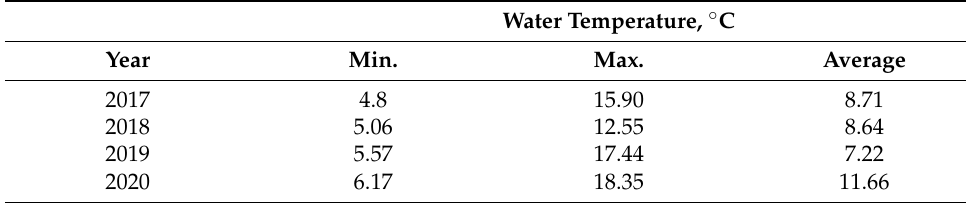
Table 5. Summarized water data for Soyang dam.